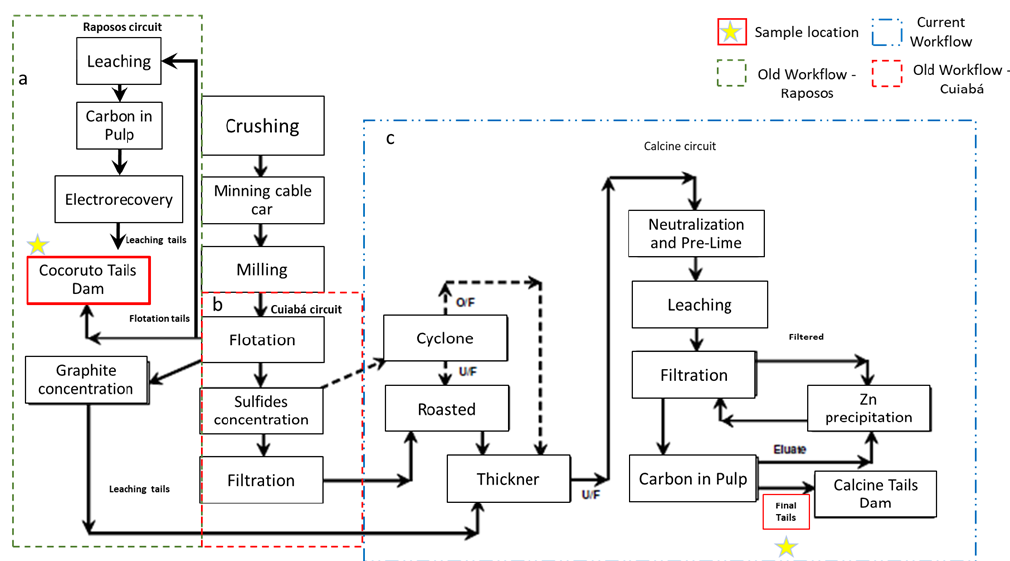
Figure 2. Old and ongoing workflow of Nova Lima´s plant ( a , b ). Old circuit sources of Cocoruto Dam. ( c ) Ongoing workflow [46]. The yellow stars represent sampling points.